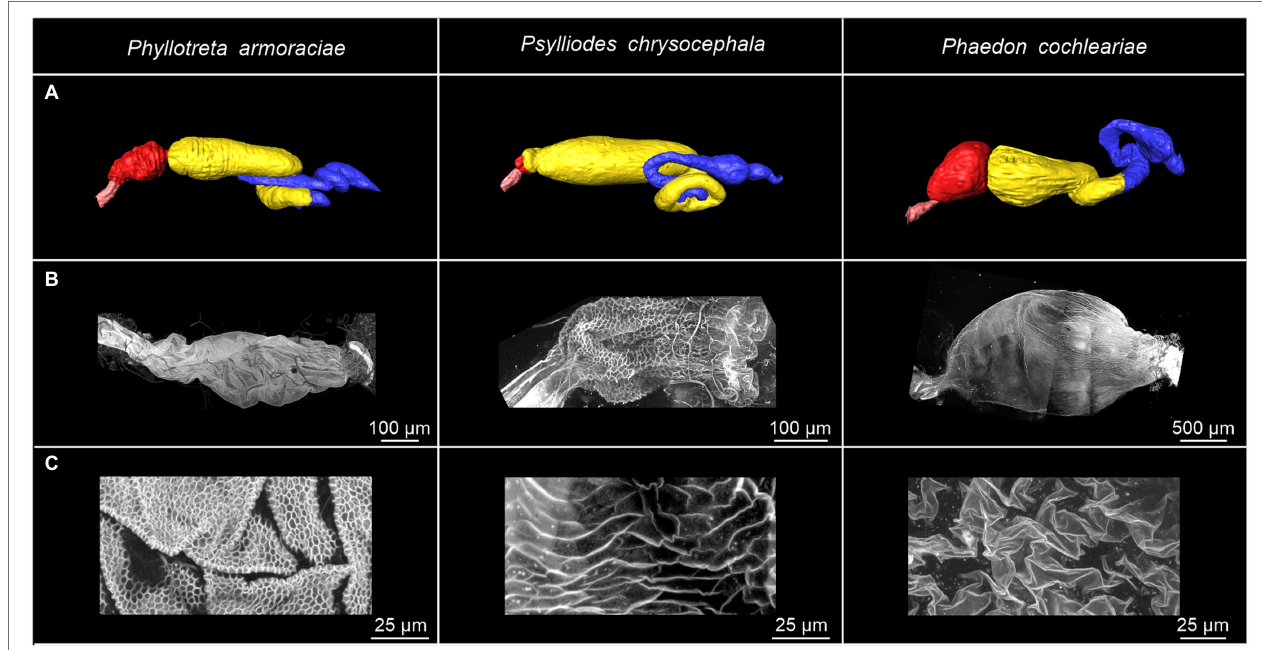
FIGURE 4 | Overview of the gut and foregut structures of Phyllotreta armoraciae , Psylliodes chrysocephala, and Phaedon cochleariae adults. (A) 3D reconstruction of the digestive systems. The esophagus, crop, midgut, and hindgut are indicated by pink, red, yellow, and blue coloration, respectively. (B,C) Autofluorescence of chitin in isolated foreguts. The excitation of cuticular autofluorescence was conducted by a 405 nm laser. Emission was detected between 410 and 695